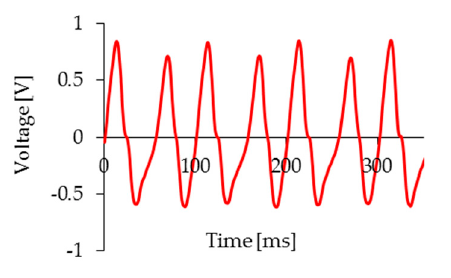
Figure 4. Open circuit voltage measured with the Halbach slider at 10 Hz and an acceleration of 8.3 m/s 2 .